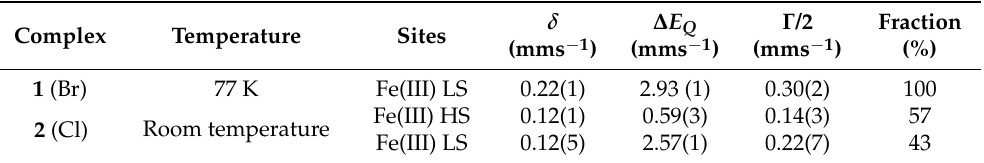
Figure 5. 57 Fe Mössbauer spectra of complexes 1 (Br) at 78 K and 2 (Cl) at room temperature. Table 3. Mössbauer parameters for complexes 1 and 2 . δ —Isomer shift (with respect to metallic α -Fe); Δ E Q —quadrupole splitting; Γ /2 = lines half width.